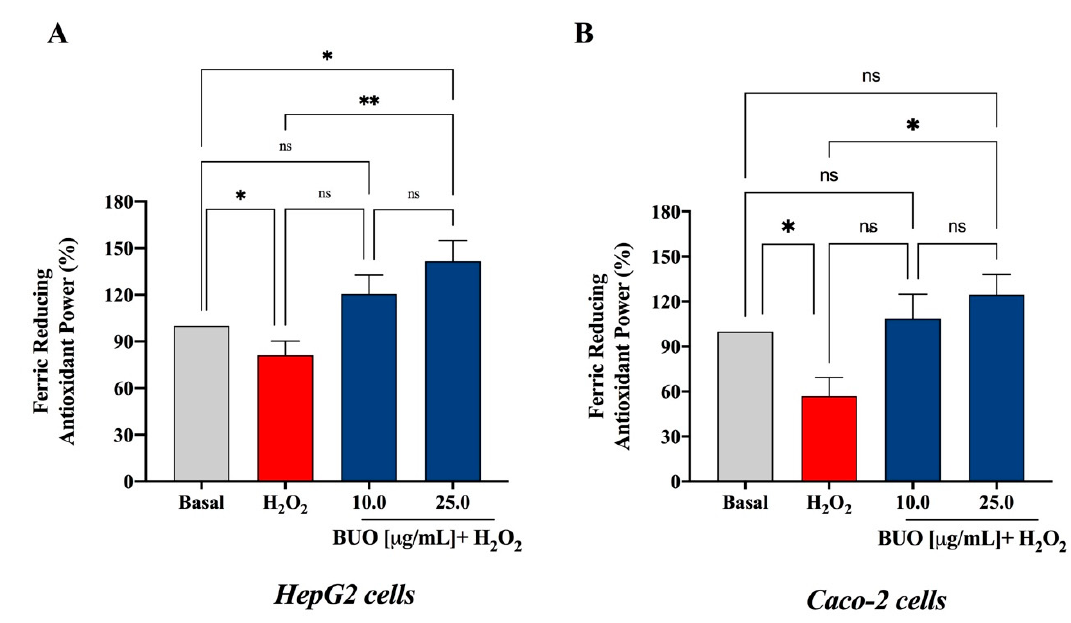
Figure 2. Antioxidant capacity of the BUO extract assayed at the cellular level, by ferric reducing antioxidant power (FRAP) assay. On ( A ) HepG2 and ( B ) Caco-2 cells, the BUO extract reverted the oxidative stress induced by 1 mM H 2 O 2 . Data represent the mean ± SD. of three independent experiments performed in duplicate. All data sets were analyzed by One-way ANOVA followed by Tukey’s post-hoc test. ns: not significant; (*) p < 0.5; (**) p < 0.01. Basal: untreated cells.